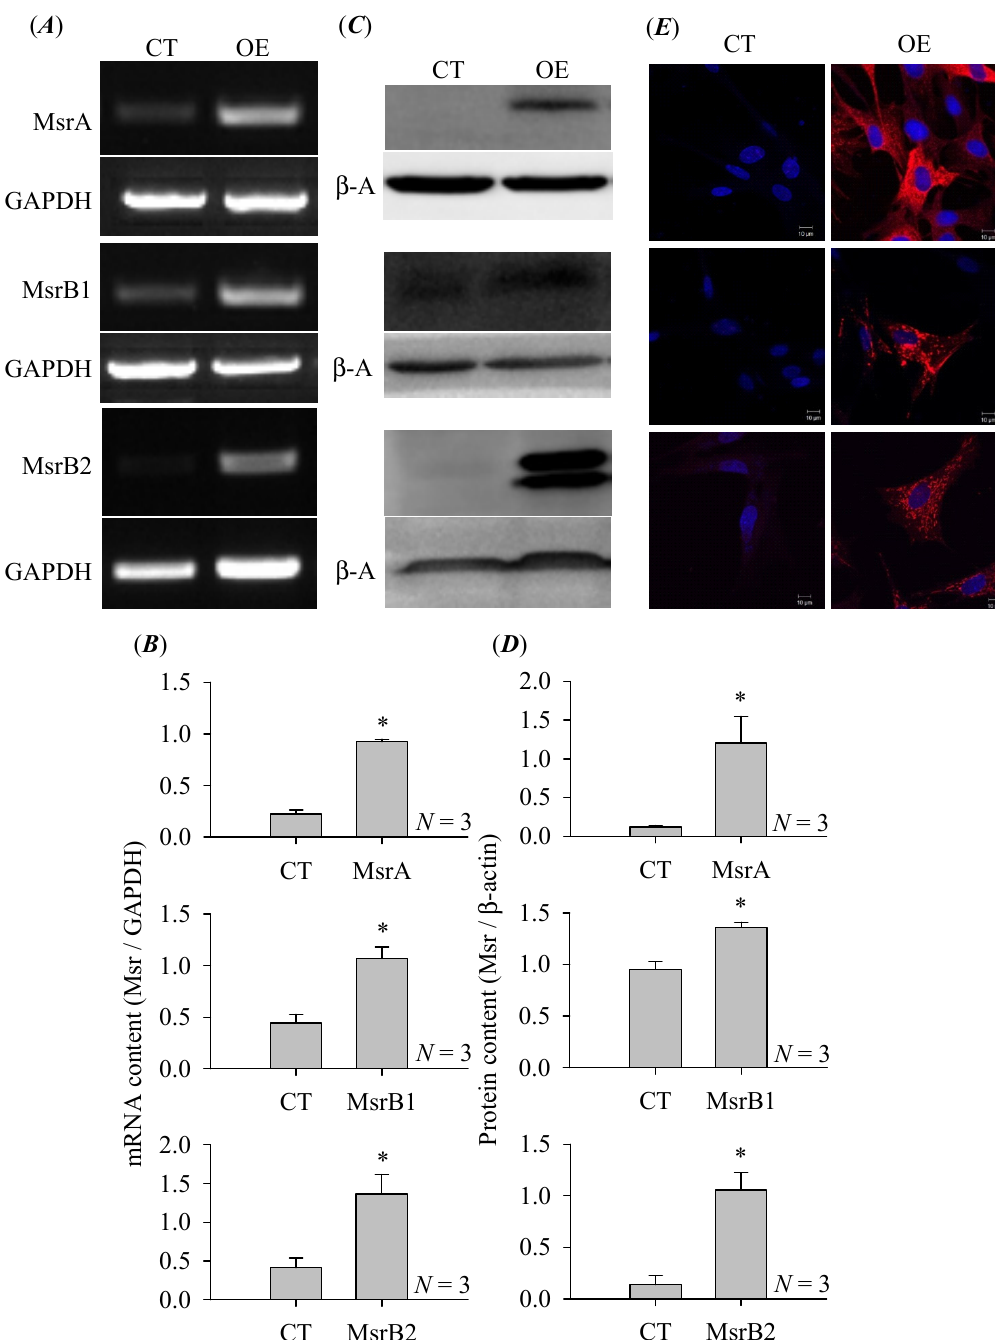
Figure 2. Msr over-expression in cultured rat pancreatic stellate cells. Pancreatic stellate cells were transfected with adenovirus vectors. MsrA, B1, B2 over-expression was detected by RT-PCR ( A , B ), Western blot ( C , D ) and immunocytochemistry ( E ), each both in control (CT) and over-expressing cells (OE). The primary antibodies: anti-MsrA, B1, 2, secondary antibody (TRITC labeled donkey anti-rabbit). Nucleus was counter-stained with Hoechst 33342. Imaging was done in a Zeiss LSM 510 META (objective 63 × /1.40 oil) with λ ex : TRITC/543 nm, Hoechst 33342/405 nm. No fluorescence was observed in time-matched control experiments (without primary and secondary antibodies, without primary antibody but with secondary antibody, non-specific rabbit IgG as primary antibody plus secondary antibody, not shown). Msr expression at the mRNA ( A ) or at the protein ( C ) levels were analyzed with ImageJ and presented as ratios of Msr/GAPDH or Msr/ β -actin ( β -A) respectively